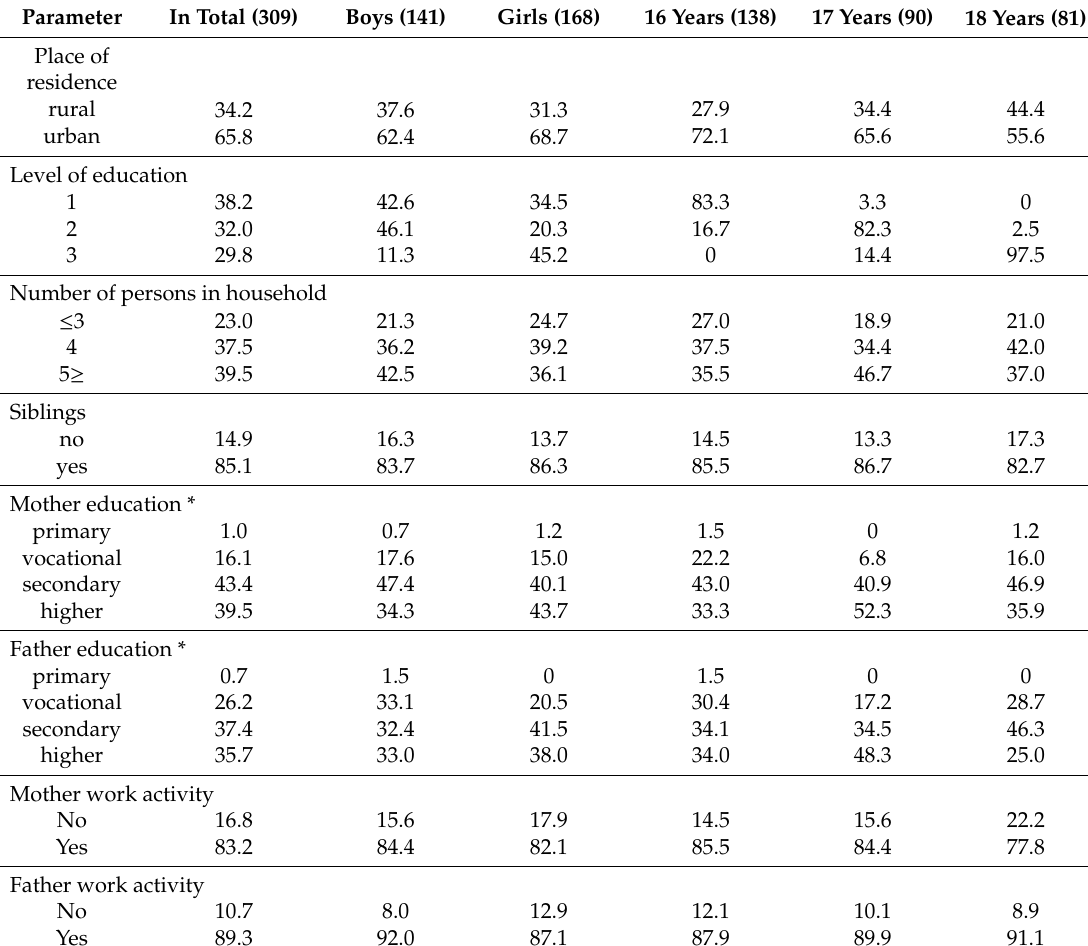
Table 1. Socio-economic and family characteristics in total and with reference to gender and age group